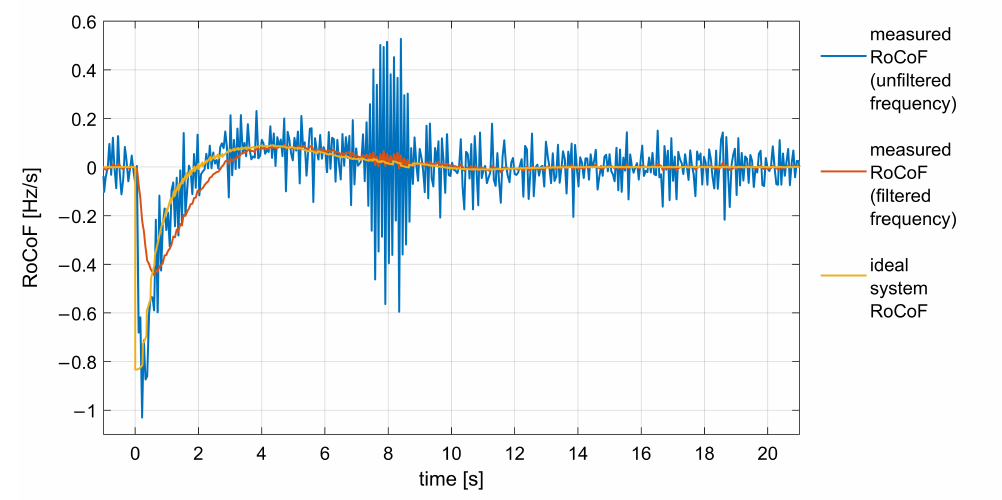
Figure 13. RoCoF measured by the controller vs. ideal simulated RoCoF.